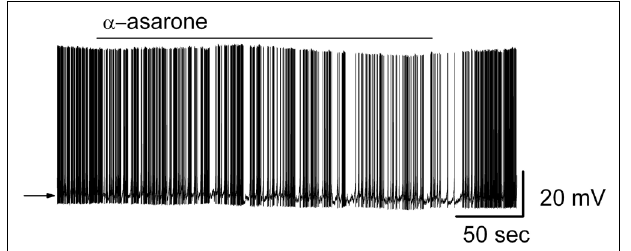
FIGURE 4 | α -asarone suppressed the spiking activity of MCs. Original recording from a representative MC. Bath application of α -asarone reduced the firing rate and hyperpolarized the membrane potential.The arrow indicates the initial level of the resting